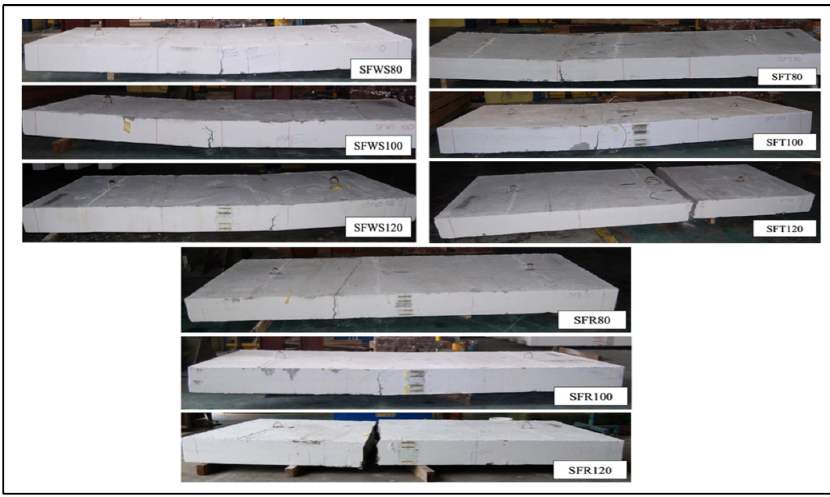
Figure 6. SCFRC ribbed slab at final